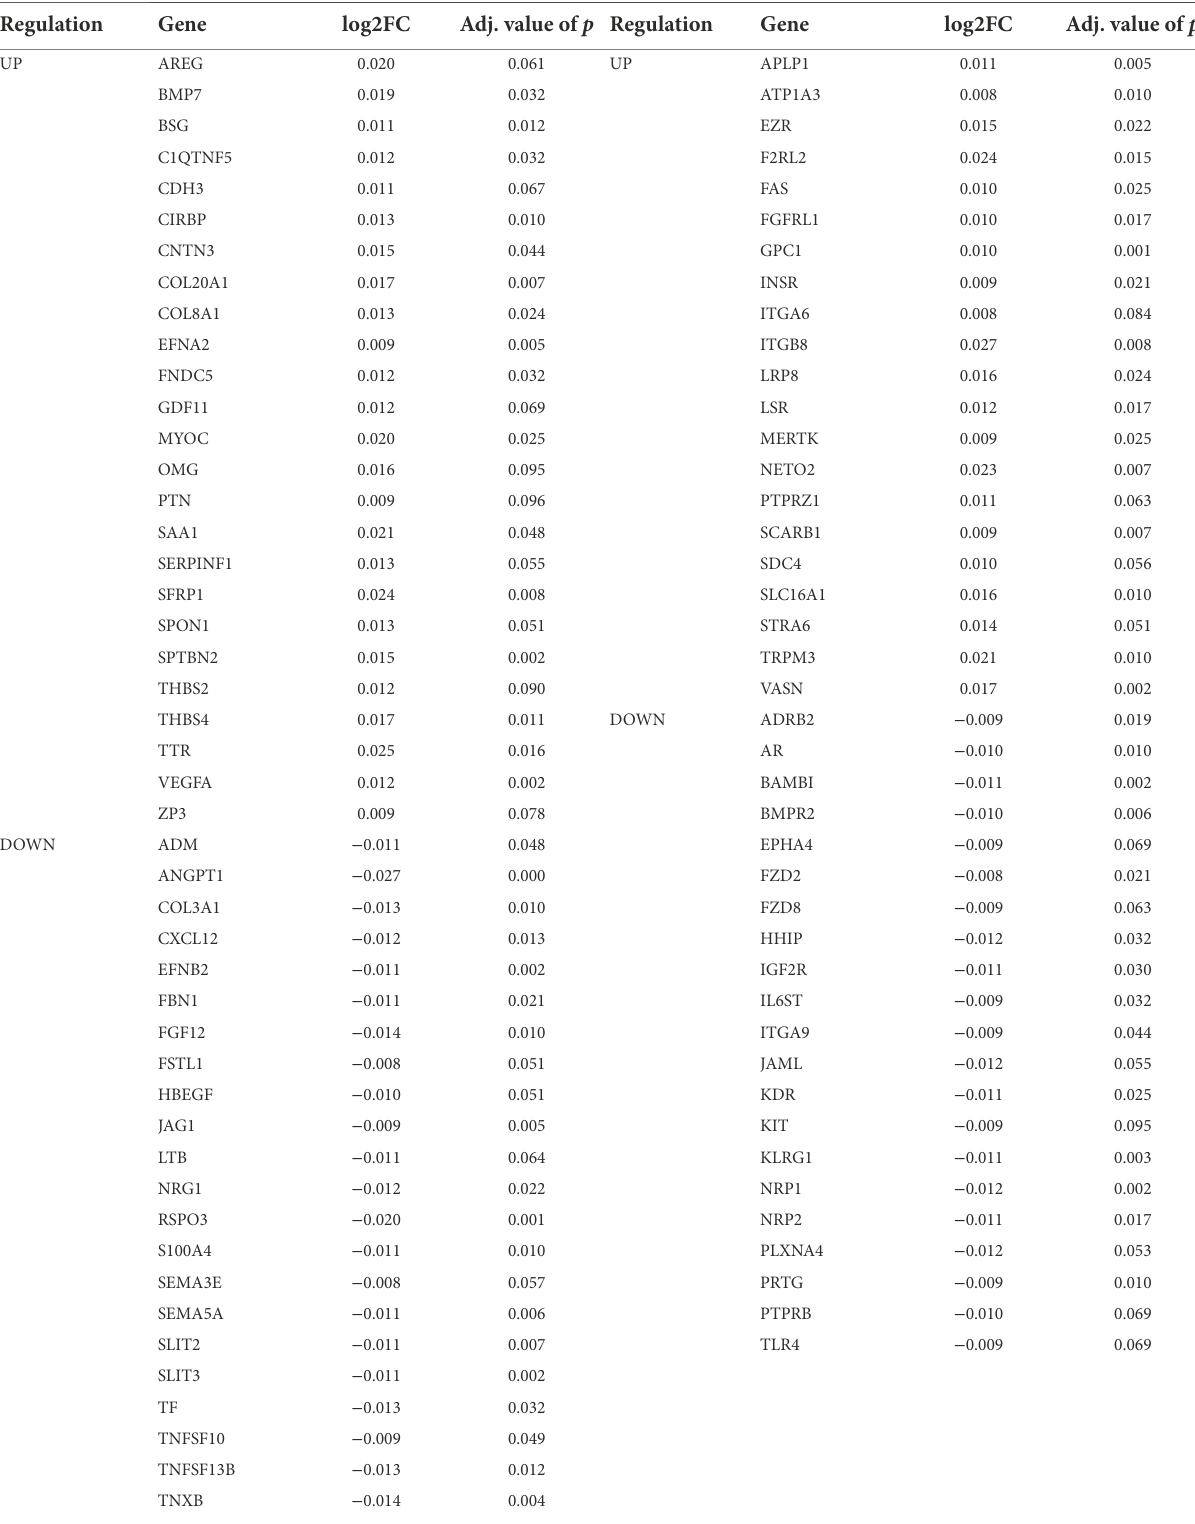
TABLE 1 Ligands and receptors that are differentially expressed with age in RPE/choroid microarray samples and taking part in cell–cell interactions (detected by scDiffCom in scRNA-seq data) specifically from or to the RPE cell type. Ligands Receptors Regulation Adj. value of p